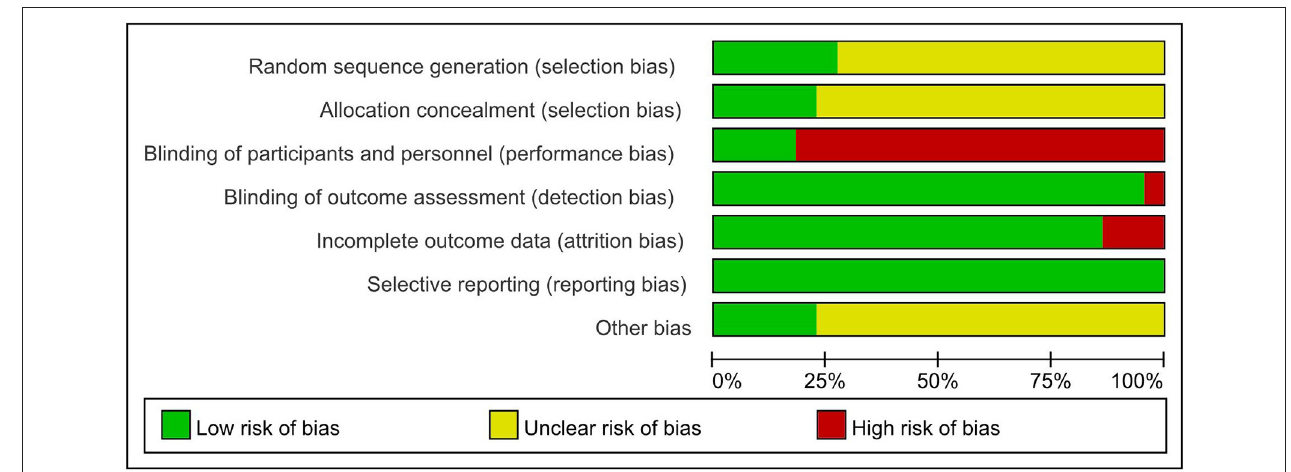
FIGURE 2 | Summary of risk of bias by